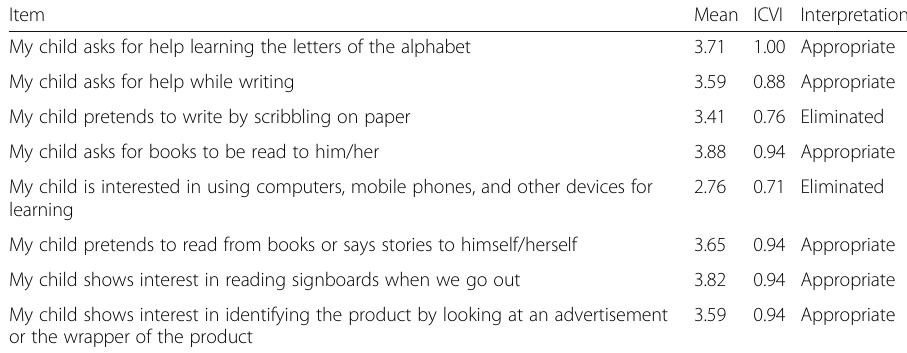
Table 3 Item Level Content Validity Index (ICVI) for the dimension “ Child literacy habits ”